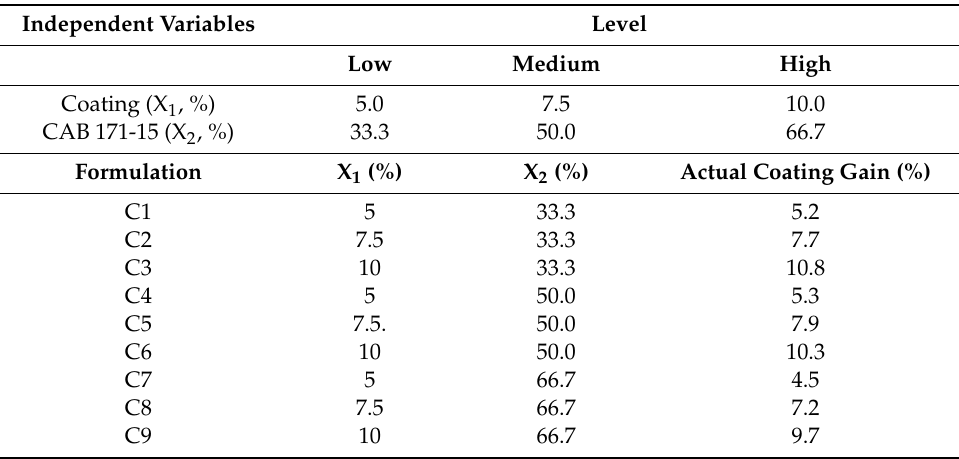
Table 1. Independent variables and experimental